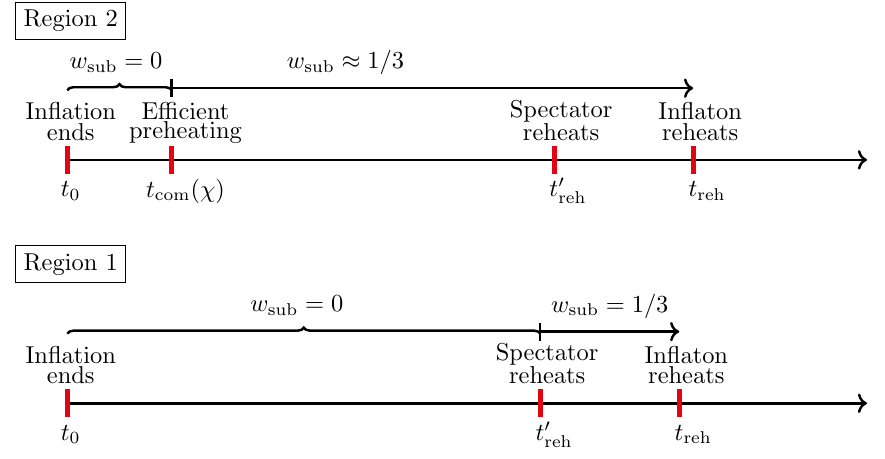
Figure 5 . Characteristic time scales in region 2 with efficient preheating of σ and region 1 with negligible preheating of σ . We also indicate w sub